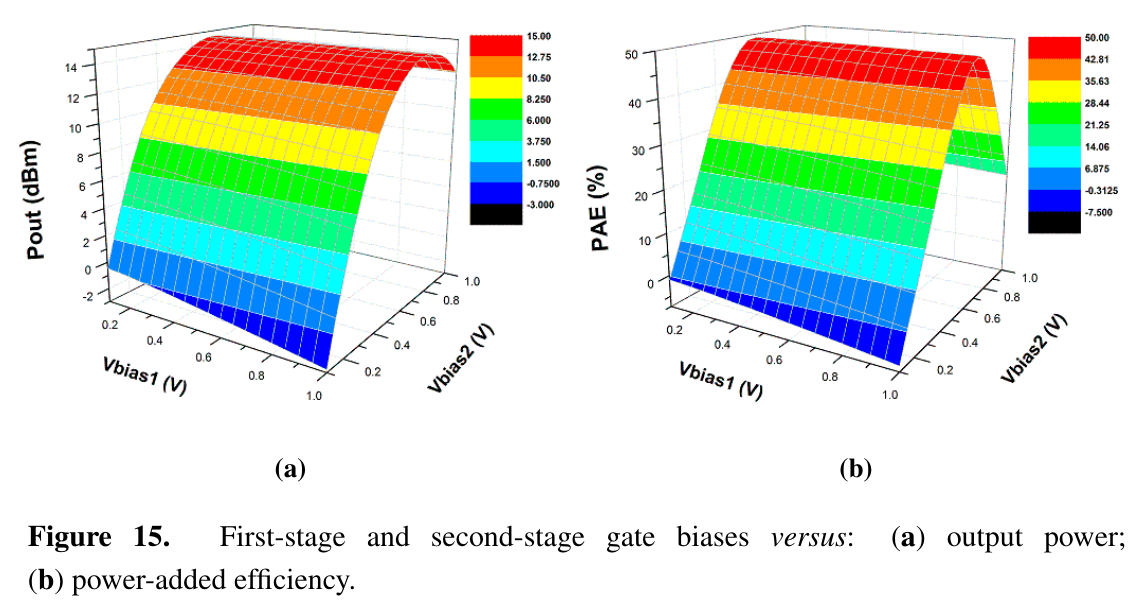
Figure 15. First-stage and second-stage gate biases versus : ( a ) output power; ( b ) power-added